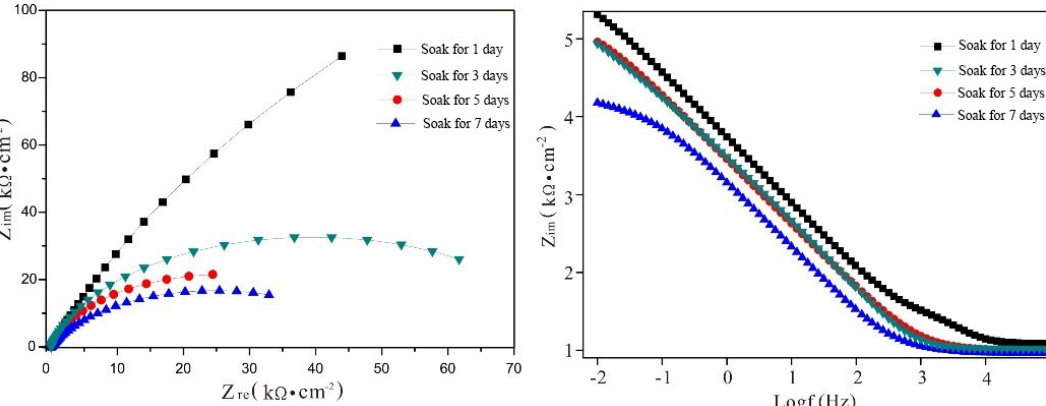
Figure 15. Nyquist and Bode diagrams of 3D-printed + corroded samples immersed in simulated seawater for different times.